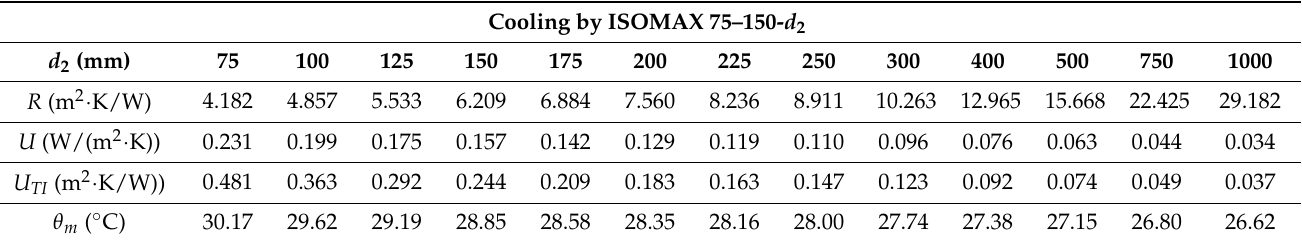
Table 2. Results of calculation of physical quantities during the cooling season. Table 1. Results of calculation of physical variables during the heating season.